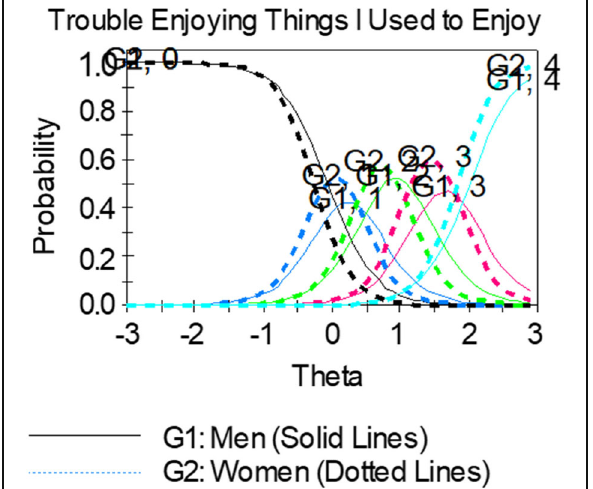
Fig. 3 Example of an item showing uniform b -DIF. Women (dotted lines) consistently endorsed higher levels of depression (their curves are shifted to the left of men in every response